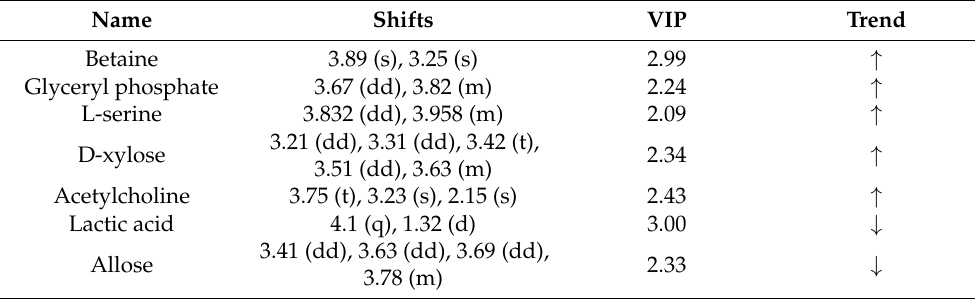
Table 4. Differently expressed metabolites in the SPM group compared with the DSS